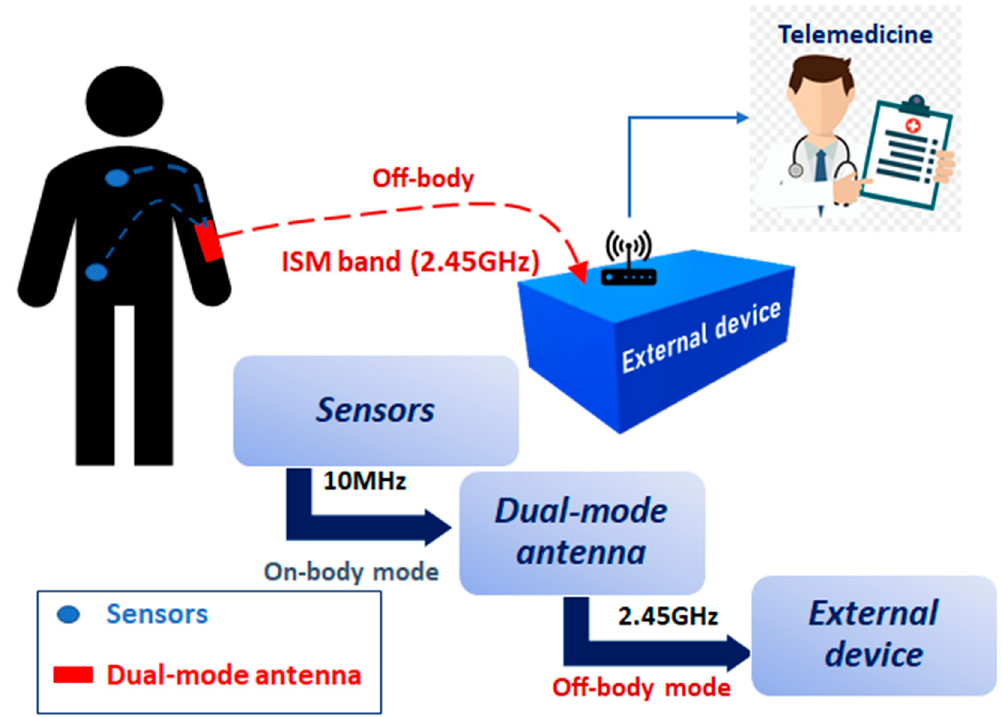
Figure 1. Proposed health monitoring system [16]. ISM band: Industrial Scientific Medical band.